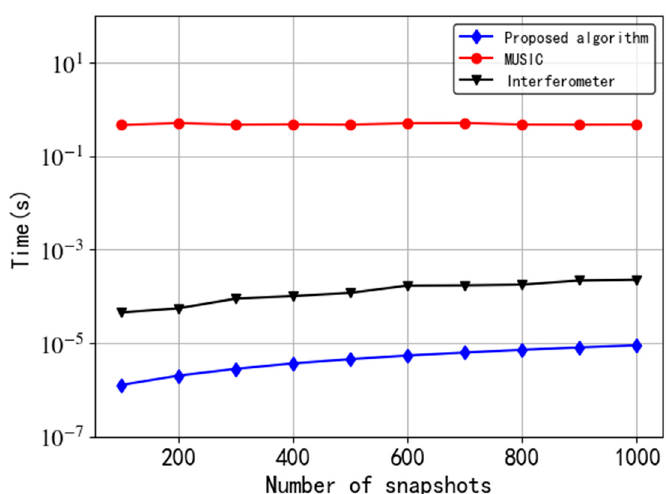
Figure 8. Relationship between operation time and the number of snapshots.